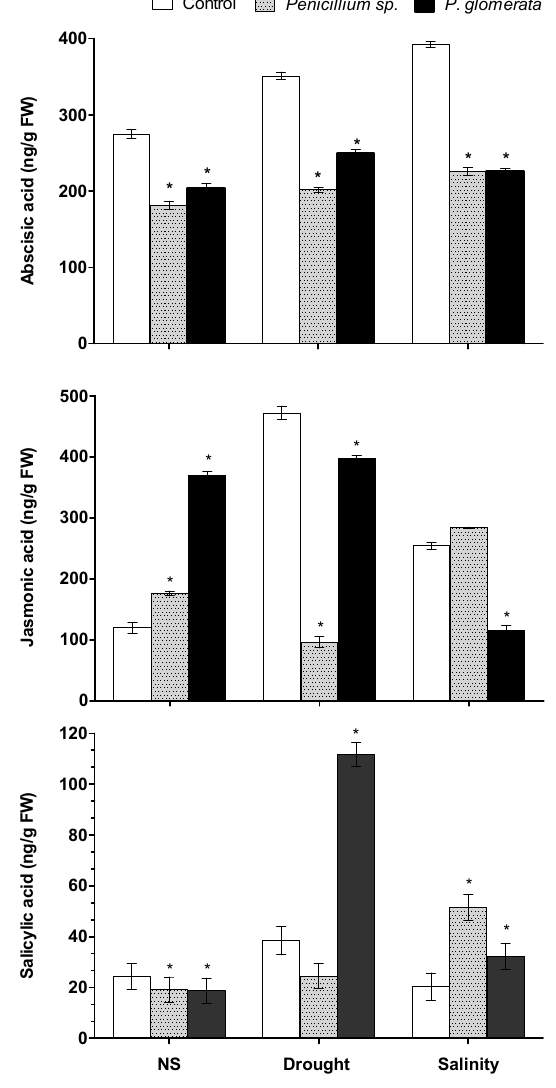
Figure 6. Phytohormonal (abscisic acid—ABA; salicylic acid—SA and jasmonic acid—JA) regulation of endophyte ( Penicillium sp. and P. glomerata ) and abiotic stress-treated plants. The quantities were calculated on the basis of peak area ratio with the